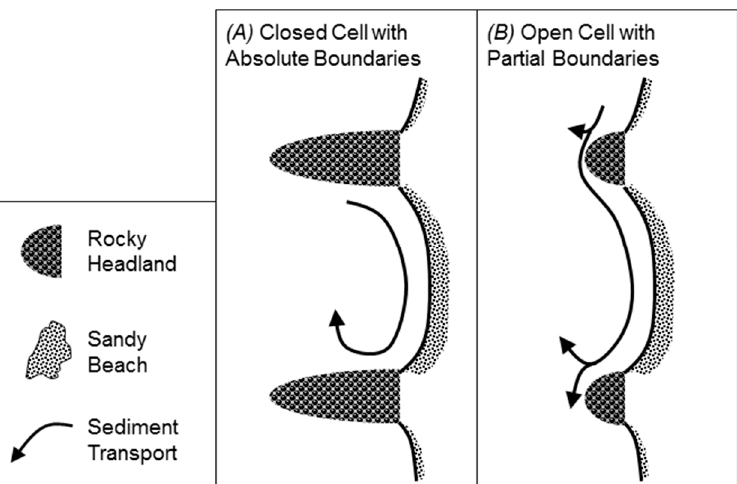
Figure 1. Conceptual littoral cell types and associated boundaries based on Davies [25] and van Rijn [20]. ( A ) A closed cell that does not allow sediment to escape to adjoining cells with absolute boundaries. ( B ) An open cell from which some sediment may be exchanged with adjoining cells, defined by partial boundaries.